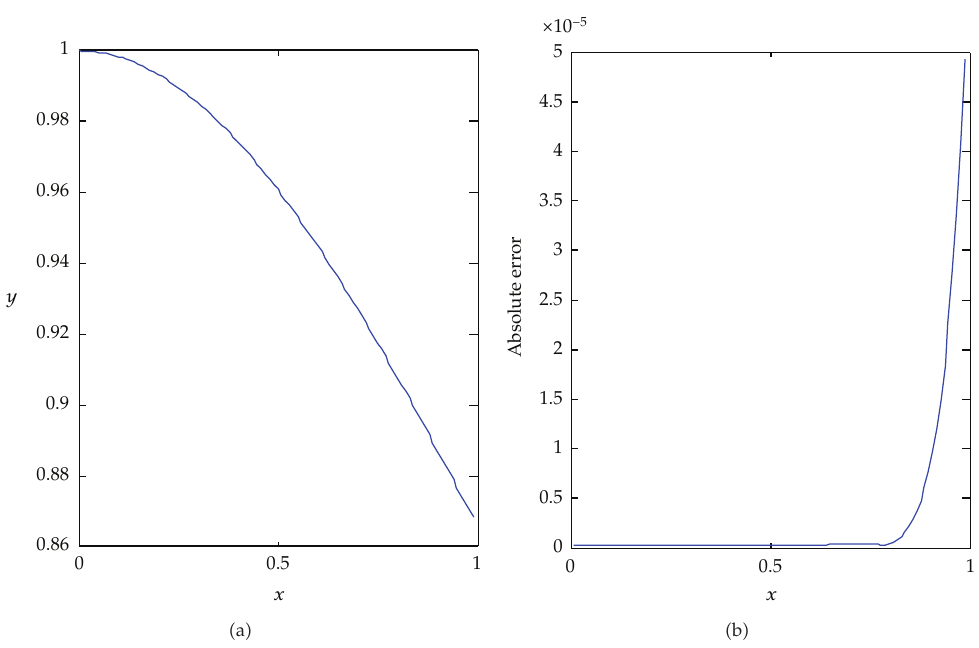
Figure 3: Numerical solution and absolute error of Example 4.2 when n (cid:7)